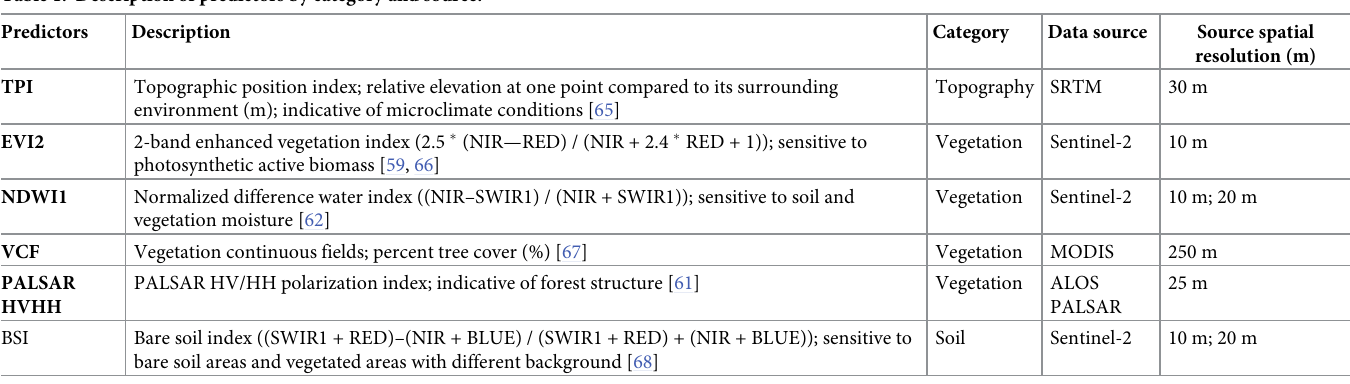
Table 1. Description of predictors by category and source.